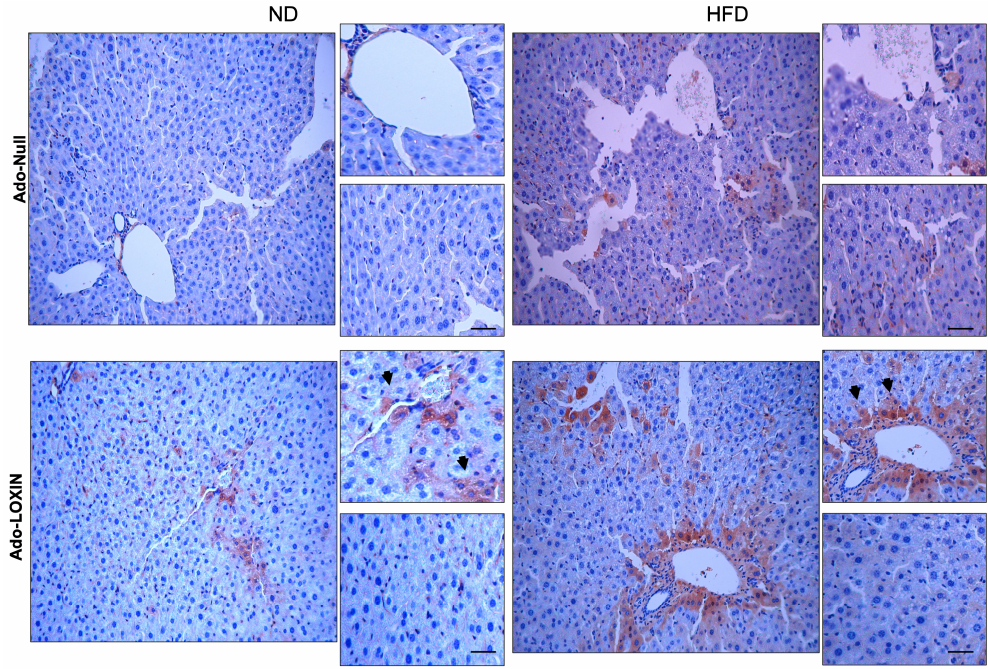
Figure 8. Hepatic IL-6 accumulation in the liver of each treated group of mice. Representative histological findings with immunohistochemical staining for IL-6 (original magnification, X400). The arrows indicate cells positive for IL-6. Scale bars indicate 10 μ m.